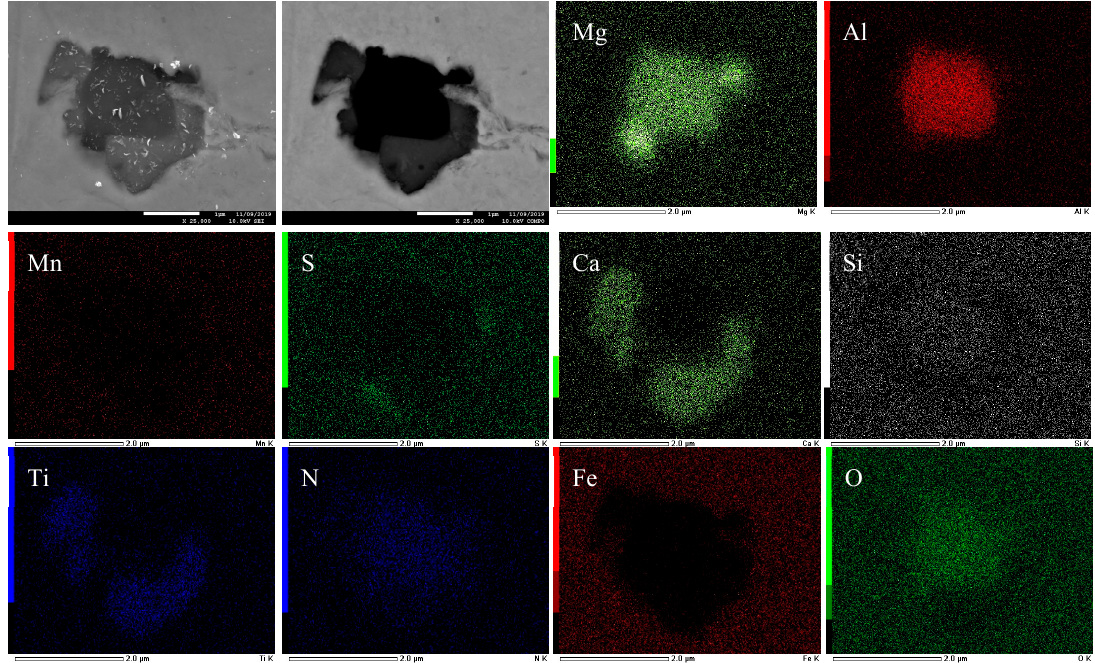
Figure 13. The element distribution of typical multiphase inclusion.